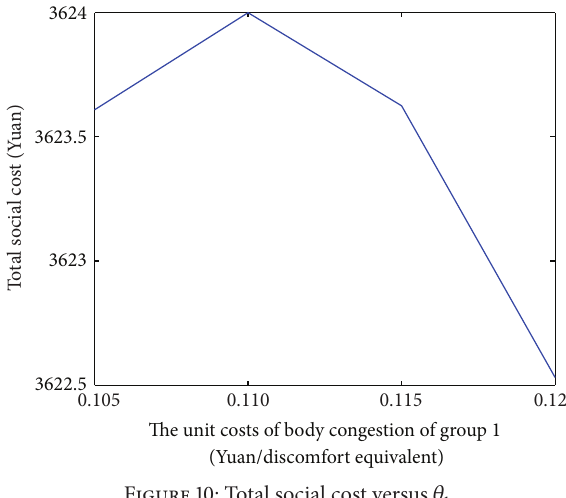
Figure 10: Total social cost versus 𝜃 1